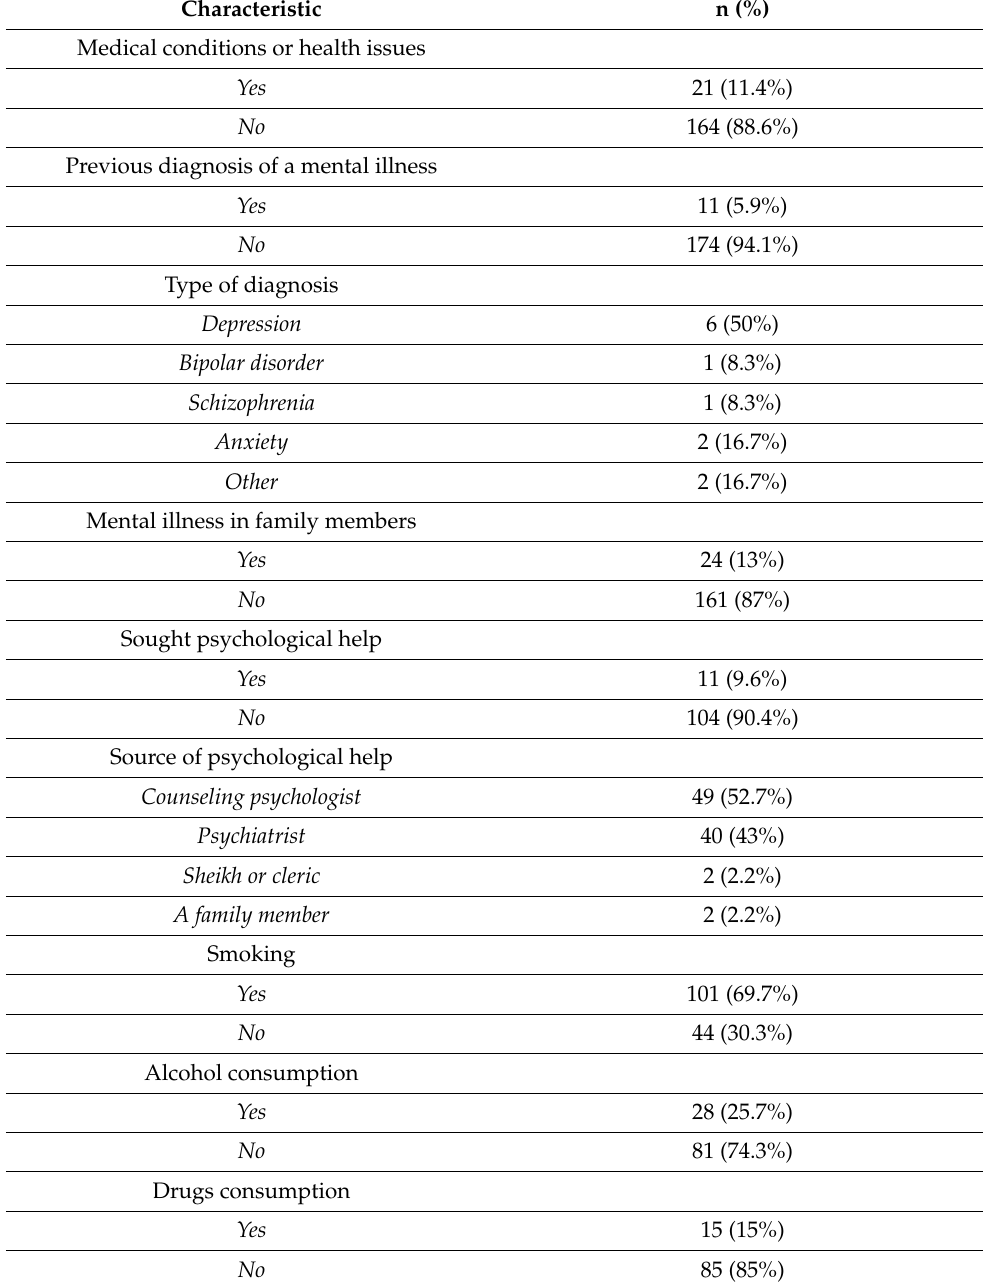
Table 2. Juvenile delinquents’ health characteristics (N =